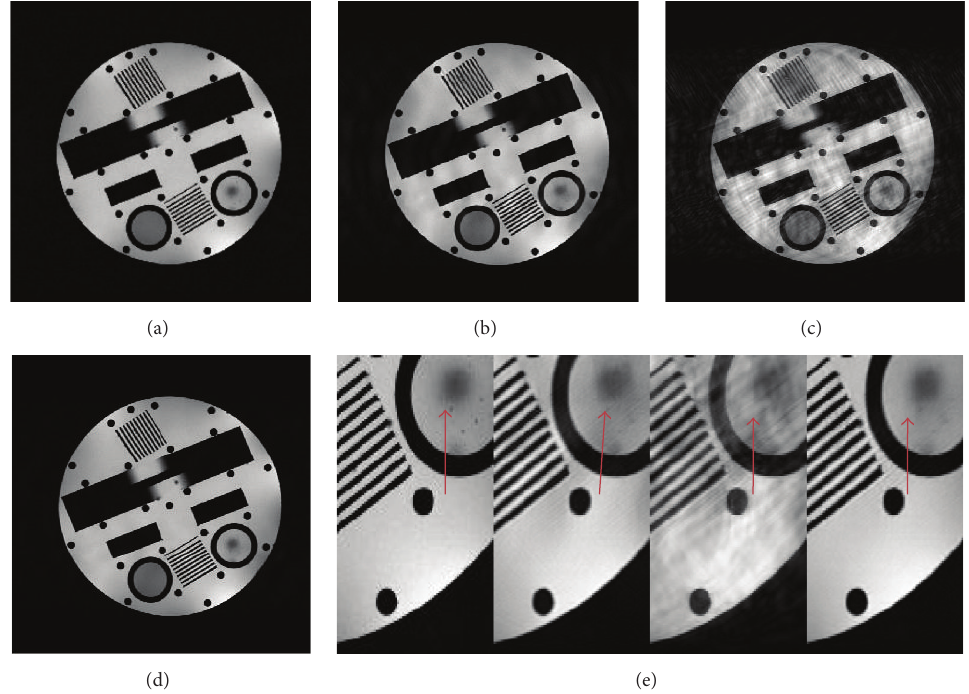
Figure 5: Reconstruction comparison of the physical phantom. (a) Fully sampled image. ((b), (c), (d)) Reconstruction results corresponding to DLMRI, SHTGV, and DLTGV at 8-fold undersampling. (e) The local area of enlargements of (a), (b), (c), and